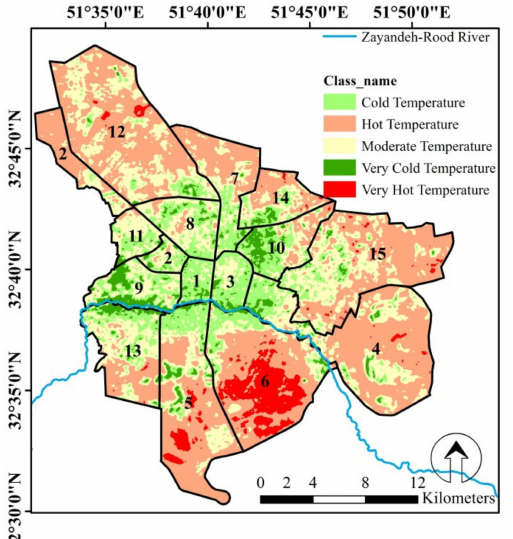
Figure 4. LST classified map of Isfahan based on mean-standard deviation method (n = 9) in the study